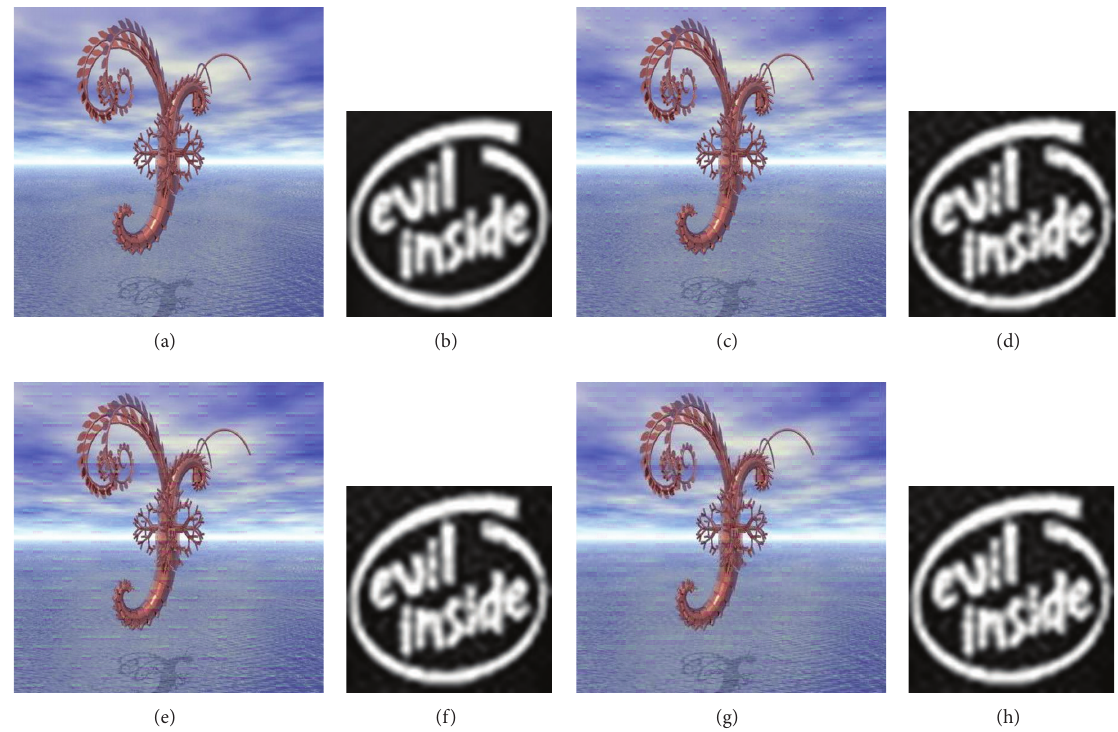
Figure 11: Comparison between the classical nonblind video multiple watermarking system (grayscale image watermark) and the proposed method where (a) and (b) show original video frame and original watermark, (c) and (d) show watermarked video frame and recovered watermark without interlacing, (e) and (f) show watermarked video frame and recovered watermark with one-level interlacing, and (g) and (h) show watermarked video frame and recovered watermark with two-level